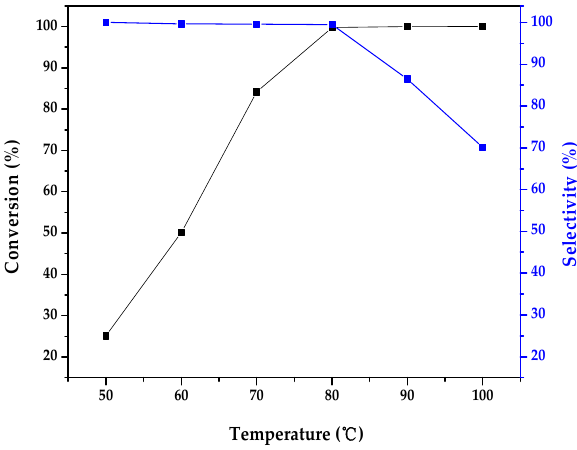
Figure 8 . Impact of reaction temperature on the conversion (black) and selectivity (blue) in the selective hydrogenation of p ‐ CNB. Reaction conditions: 1 g 0.27 wt % modified Pd/ γ ‐ Al 2 O 3 @ASMA treated with 100 g/L morpholine, 1 g p ‐ CNB dissolved in 50 mL ethanol, 600 rpm, 2 MPa H 2 pressure, and 4 h in a 100 mL autoclave.